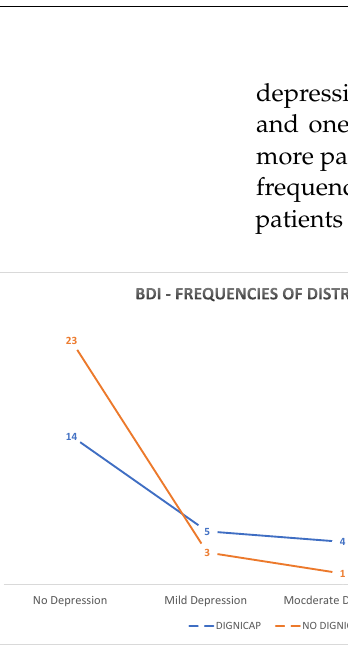
Figure 3. Frequencies of distribution of DG and NDG patients in BDI test. One-way ANOVA was performed comparing the PDI and BDI total scores for the DG and NDG groups. Statistical analysis showed a significant difference in BDI score (F(1,28) = 41.8; η 2 = 0.08; p = 0.02), evidencing the higher depression risk in the DG group, as shown in Table 2 and Figure 4. Table 2. Raw score and one-way ANOVA for Research Protocol.